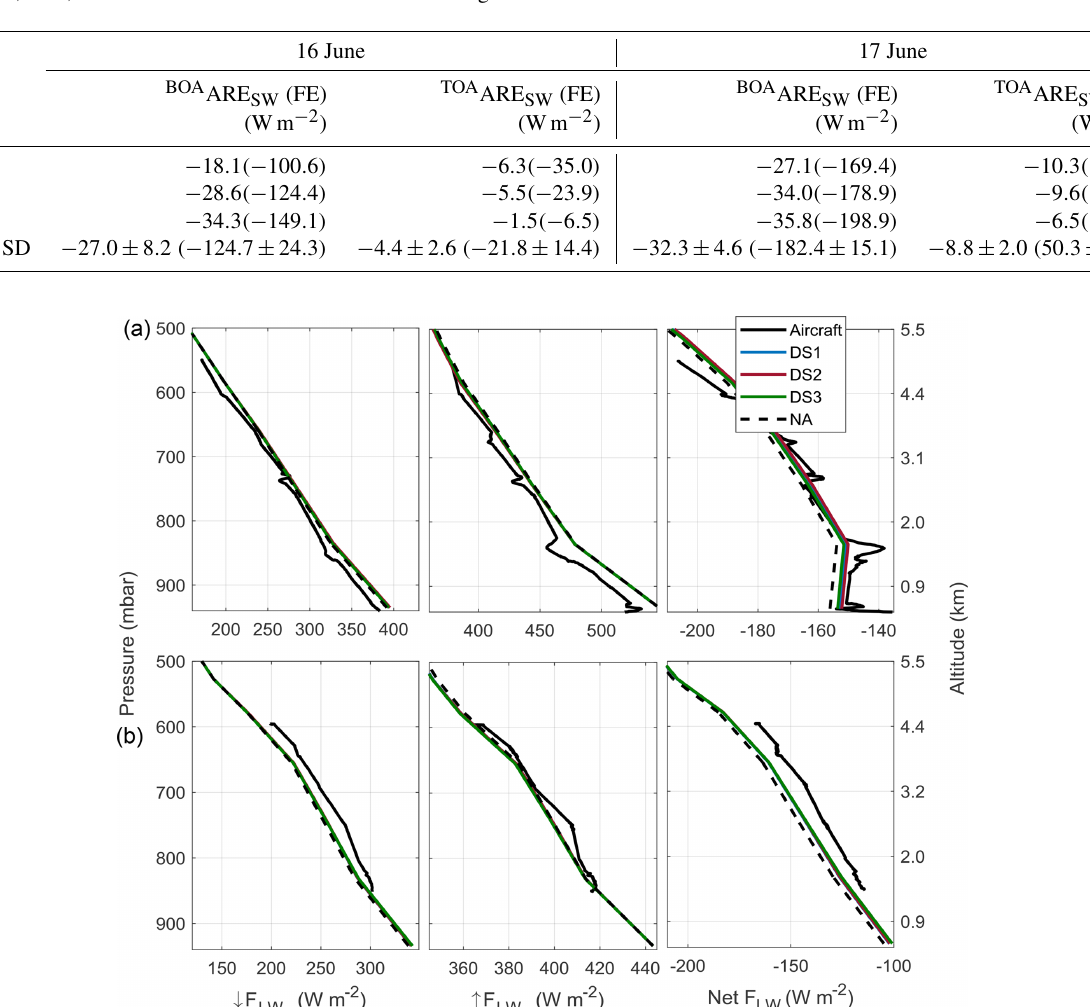
Figure 9. Radiative fluxes for the LW spectral range for 16 June (a) and 17 June (b) simulated with GAME using different input aerosol datasets (DS1 in blue, DS2 in red, and DS3 in green). The black line represents the aircraft in situ measurements. The dashed black lines represent the radiative fluxes without the aerosol component